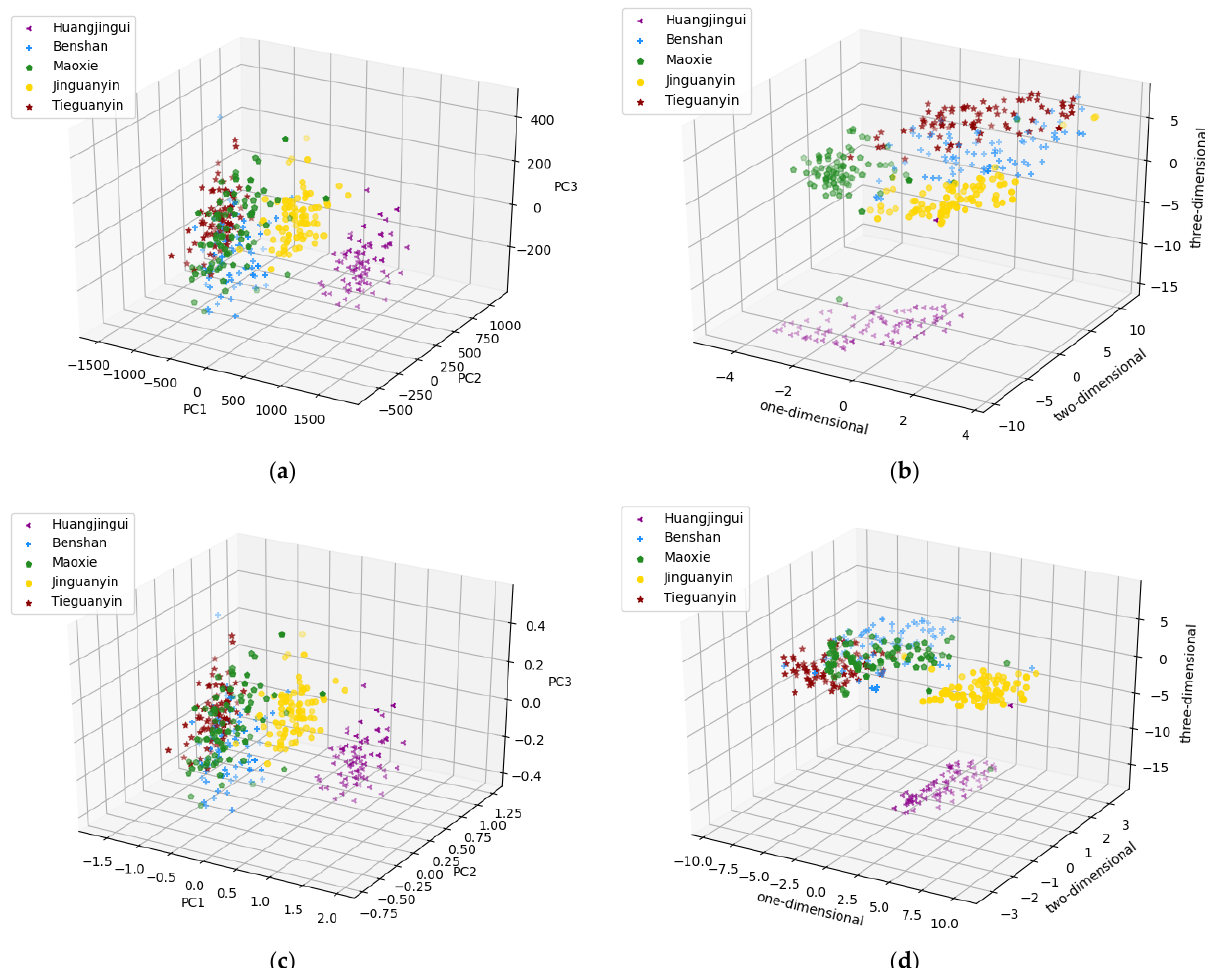
Figure 10. Visual diagrams of two feature selection methods when reduced to three dimensions ( a ) MSC-PCA, ( b ) MSC-t-SNE, ( c ) SNV-PCA, ( d ) SNV-t-SNE.